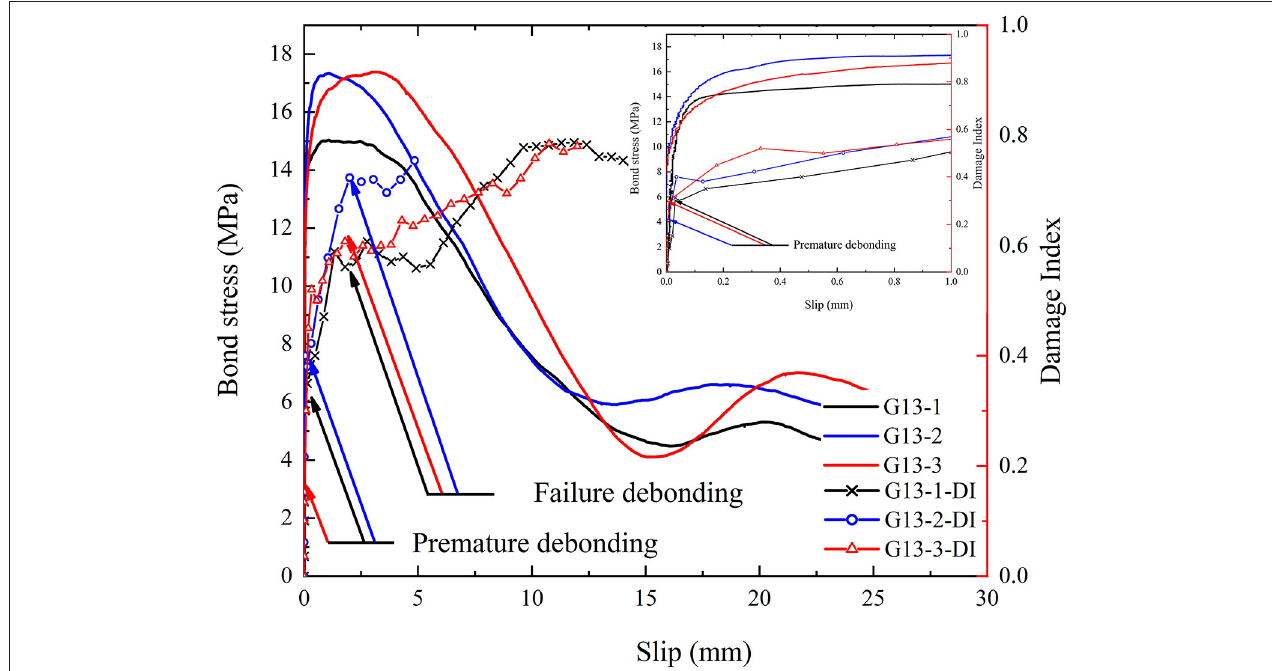
FIGURE 11 | Damage Index and bond stress-slip curves of